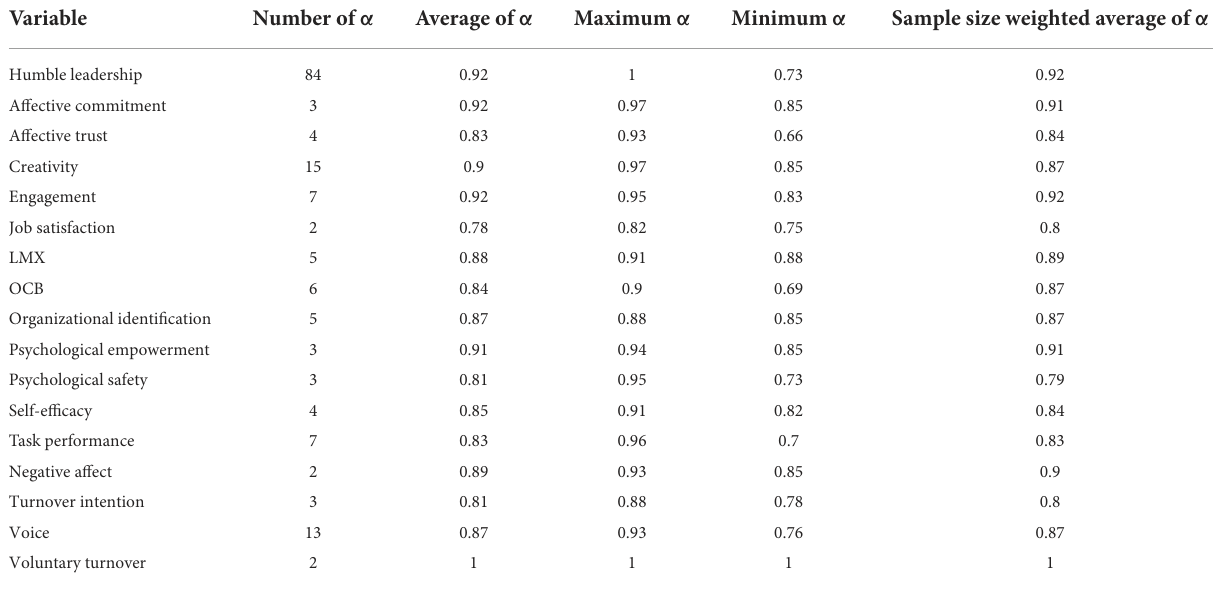
TABLE 3 Cronbach’s α reliabilities of the current